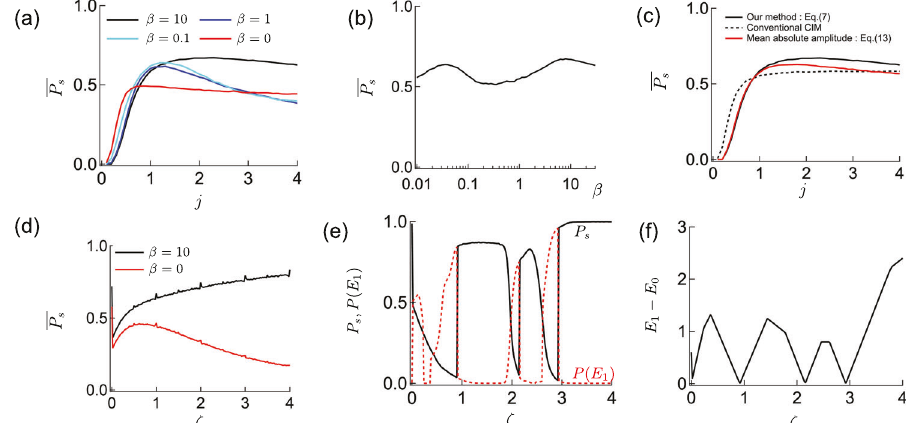
Fig. 5 16-spin random model with Zeeman terms. a Coupling strength j dependent success probability. b β (strength of amplitude control) dependence ( j = 2). c Comparison of j -dependence for β = 10 coherent Ising machine (CIM) and previously considered models, conventional CIM which doesn't have amplitude control and Zeeman terms, and β = 10 amplitude controlled CIM with Zeeman terms provided by Eq. (13). d Dependence on the relative size of Zeeman terms ζ ( j = 2). e The success probability ( P s ) and the probability to fi nd fi rst excitation ( P ( E 1 )) of one random instance (I1). f The excitation energy of the fi rst excitation state from the ground state ( E 1 − E 0 ) in